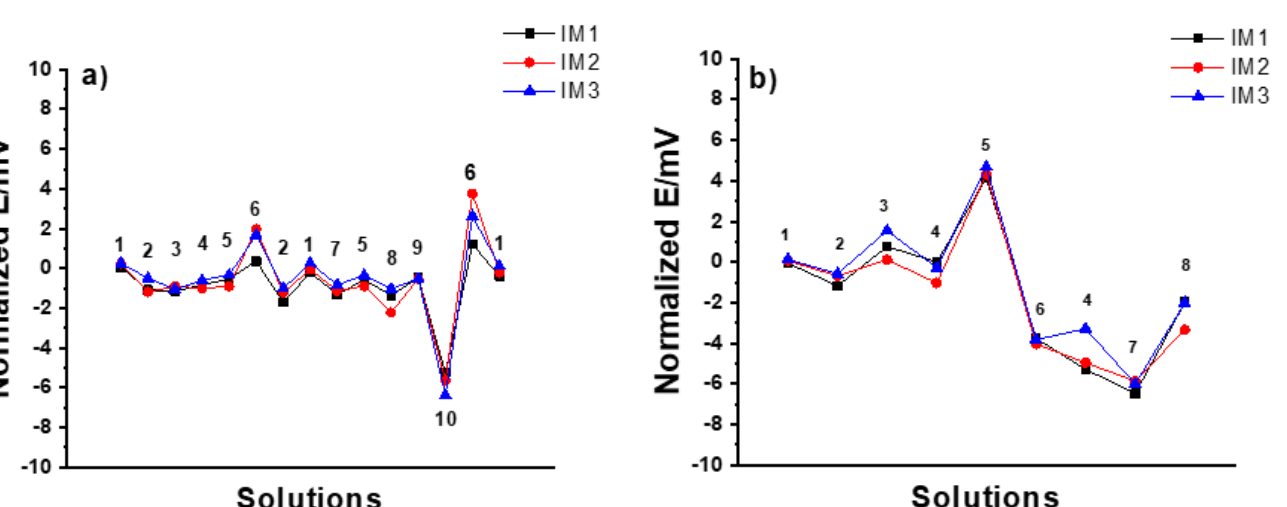
Figure 6. Results of ( a ) MSP1 (1: 3 M KCl, 2: DW, 3: 10 -2 M NaCl, 4: 10 -2 M KCl, 5: 10 -1 M KCl, 6: 10 -2